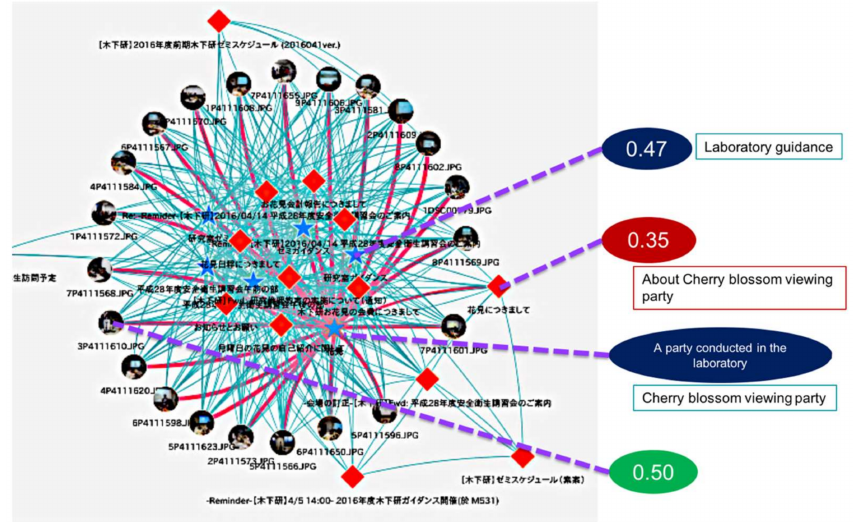
Figure 12. Result of the memory structure construction centering on the schedule of a party (Cherry blossom viewing